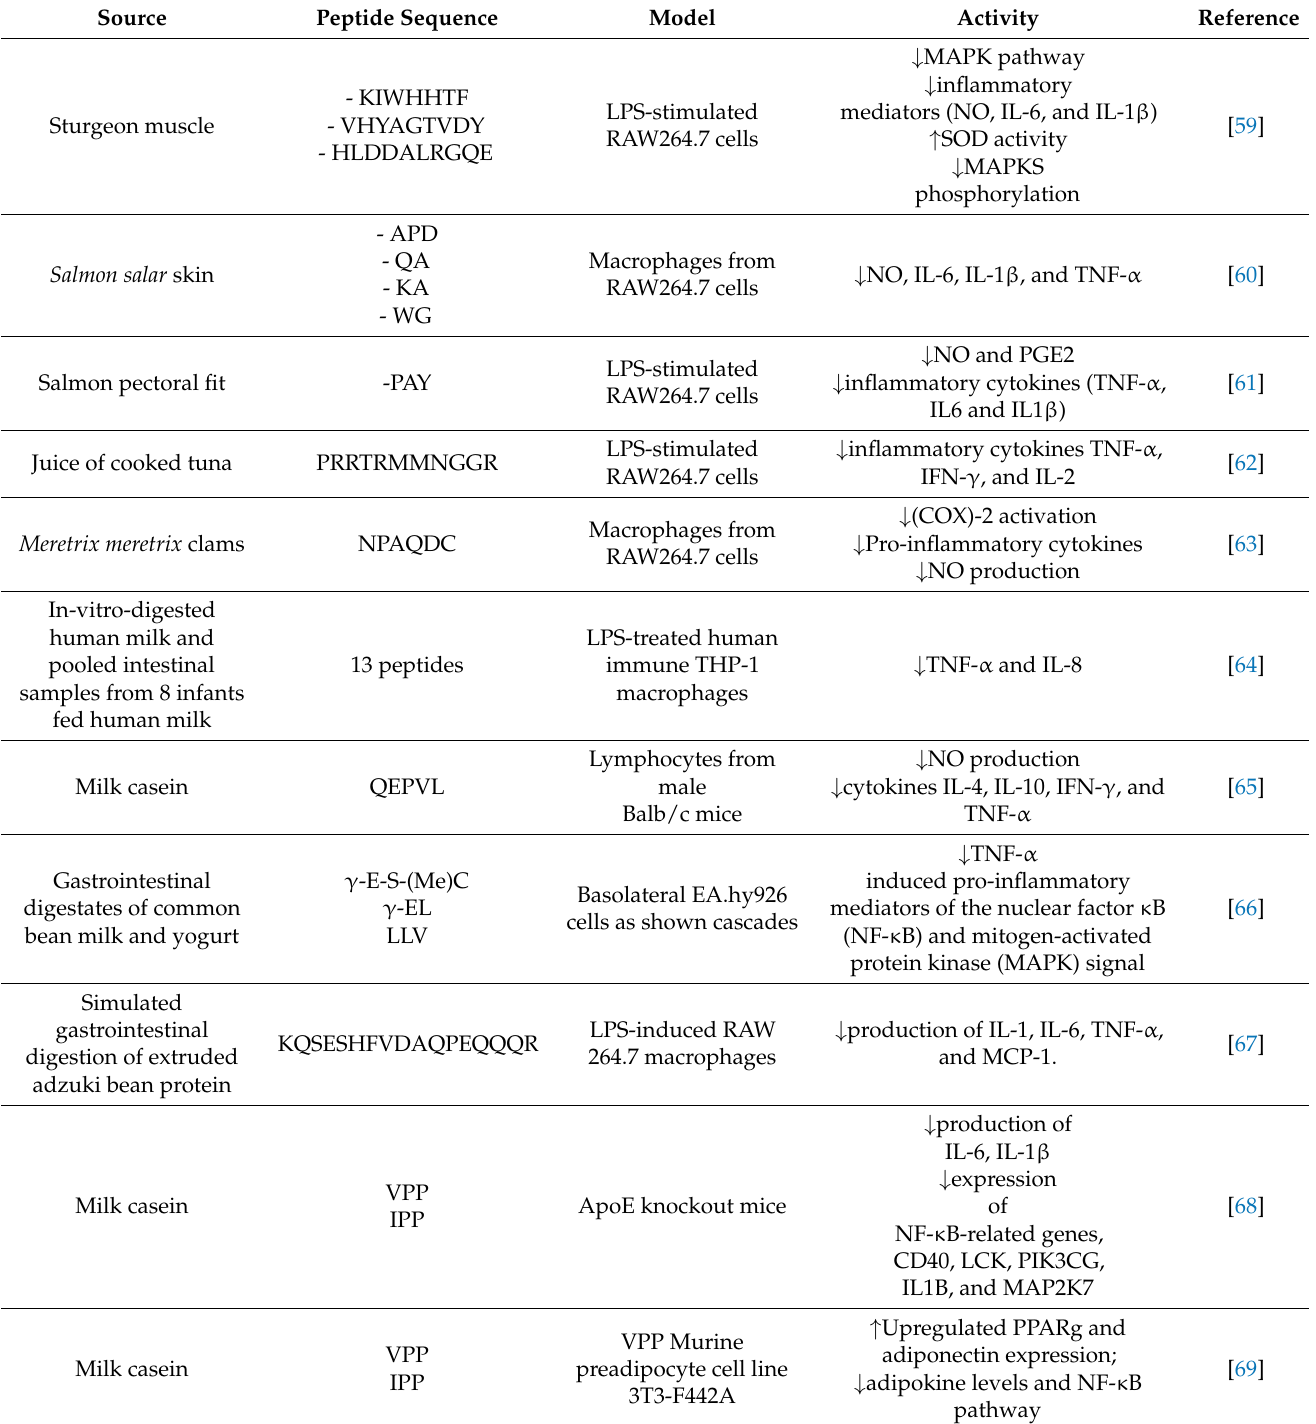
Table 3. Several bioactive peptides exhibit anti-inflammatory activity. ↑ Increase; ↓